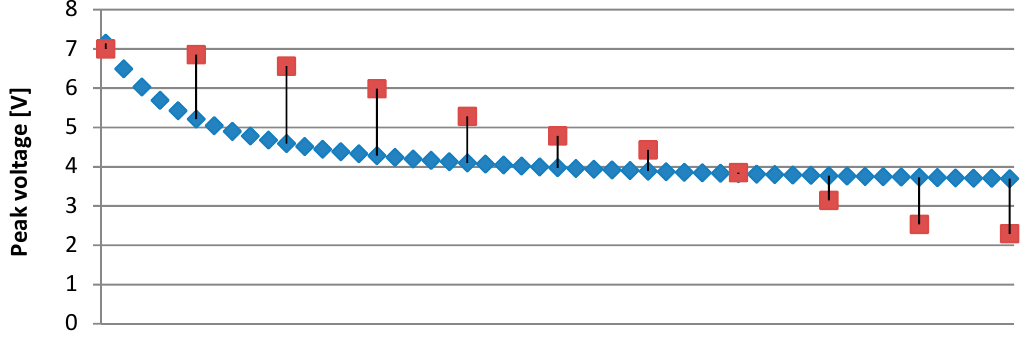
Figure 5. The calculated values of the peak voltage generated by the piezoelectric transducer juxtaposed with the measured values for different temperatures of operation.